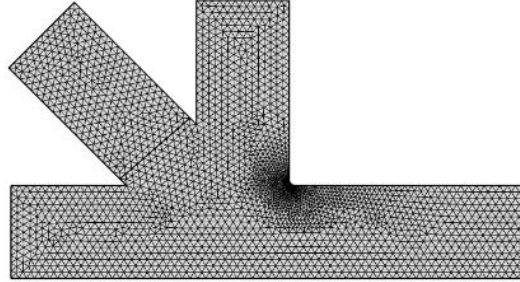
Figure 2. Created mesh for a crossed part of the channel.